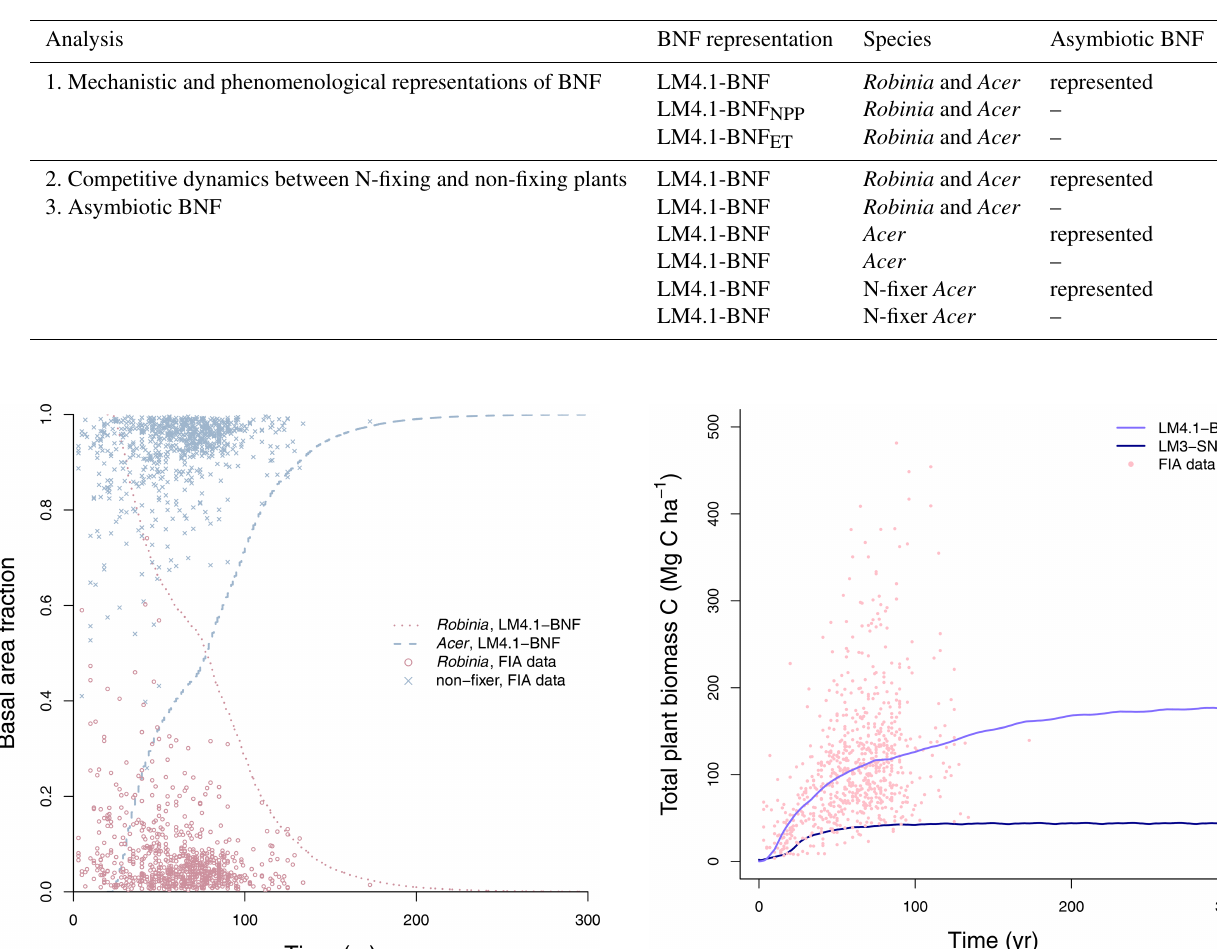
Table 2. Description of numerical experiments. In the first analysis, we compare mechanistic and phenomenological representations of BNF. In the second analysis, we examine the role of competitive dynamics between N-fixing and non-fixing plants. In the third analysis, we examine the role of asymbiotic BNF. Note that the same six numerical experiments were examined in both the second and third analyses.